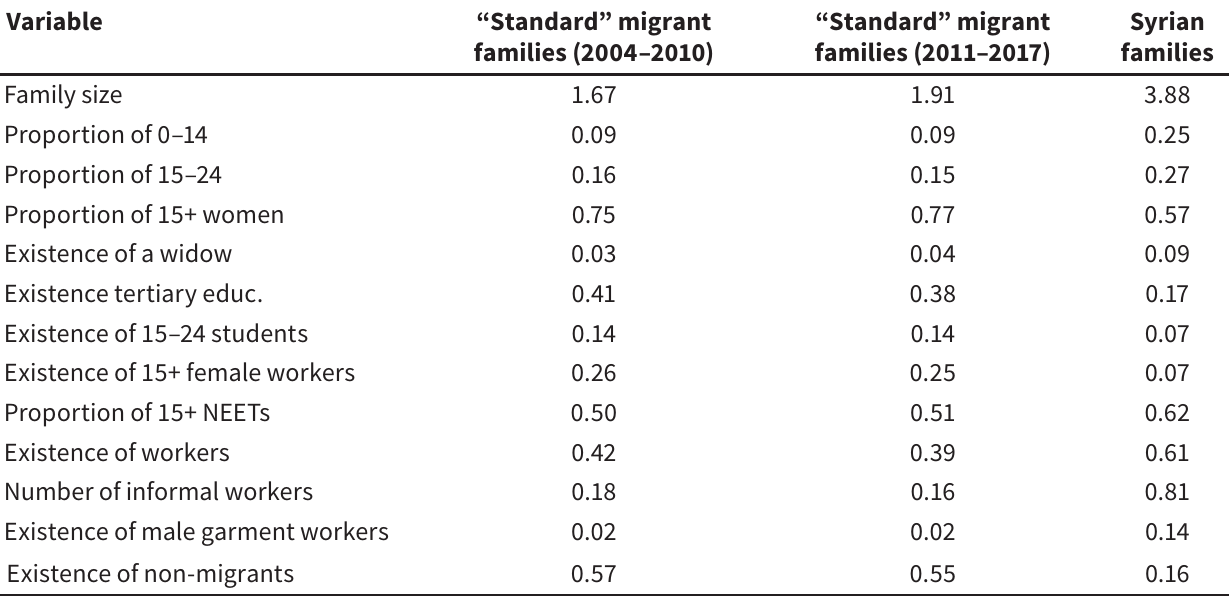
Summary statistics at the family level: after matching